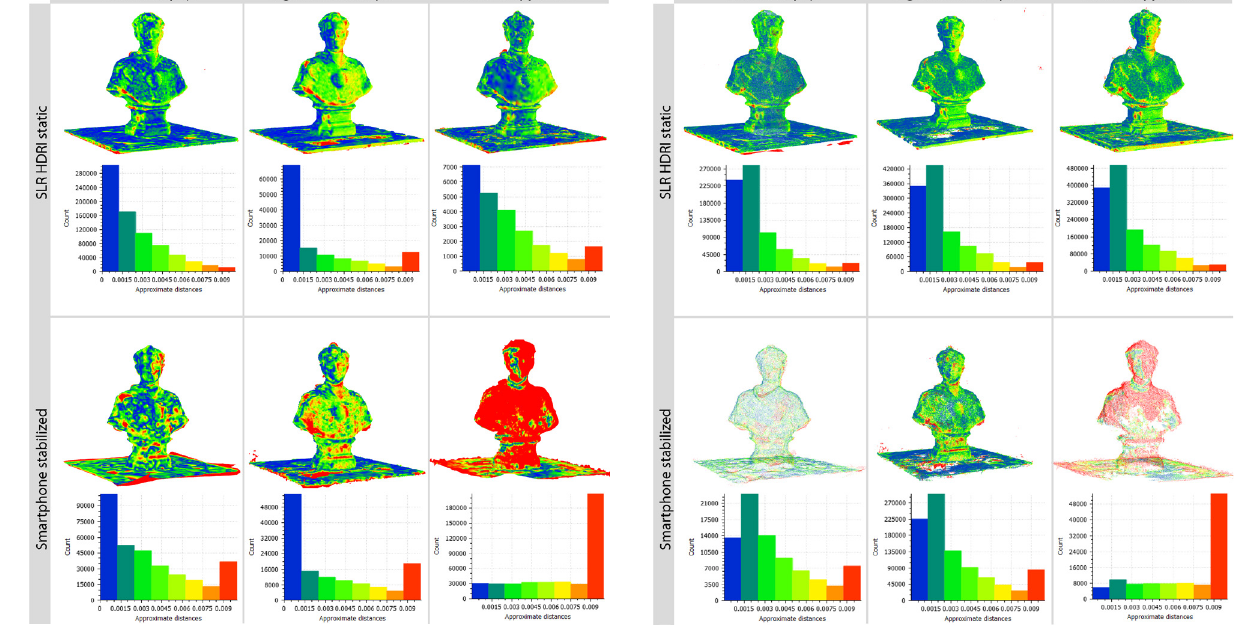
Figure 14. Comparison of the point clouds obtained by two most favourable survey technics (SLR HDR and stabilized smartphone)